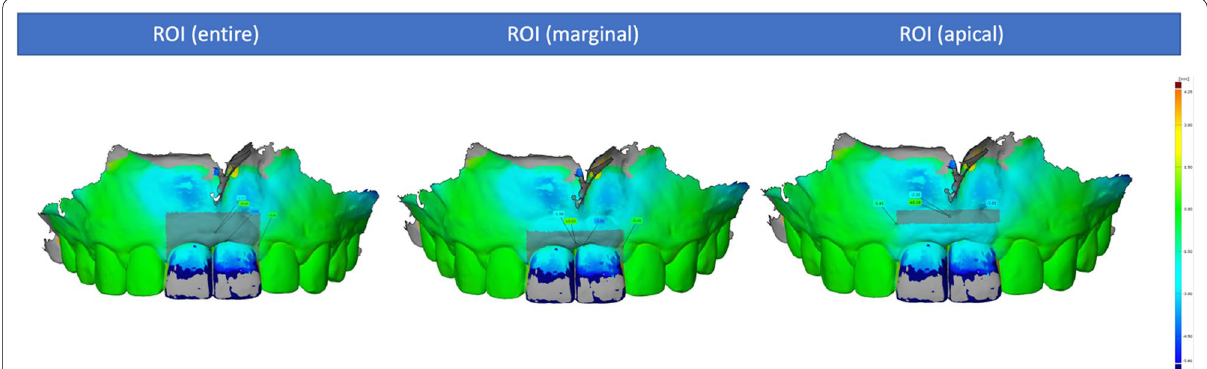
Fig. 1 Delimitation of the region of interest